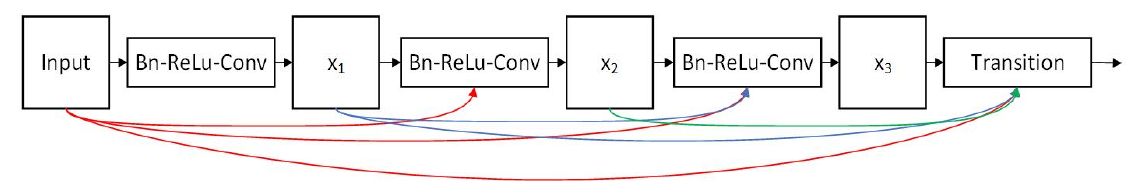
Figure 5. DenseNet structure.